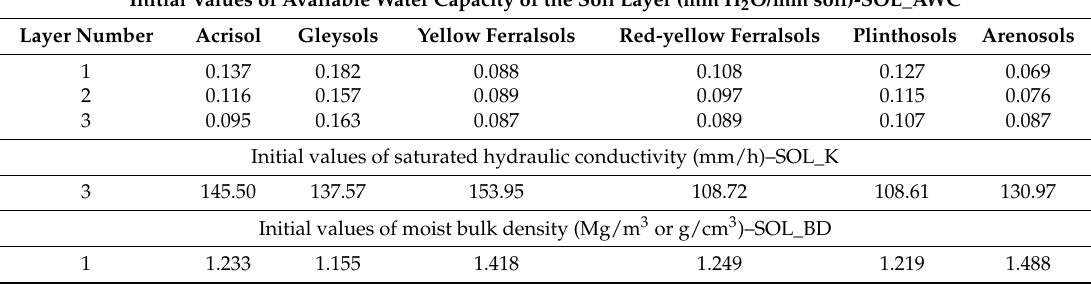
Table A1. Initial values of soil